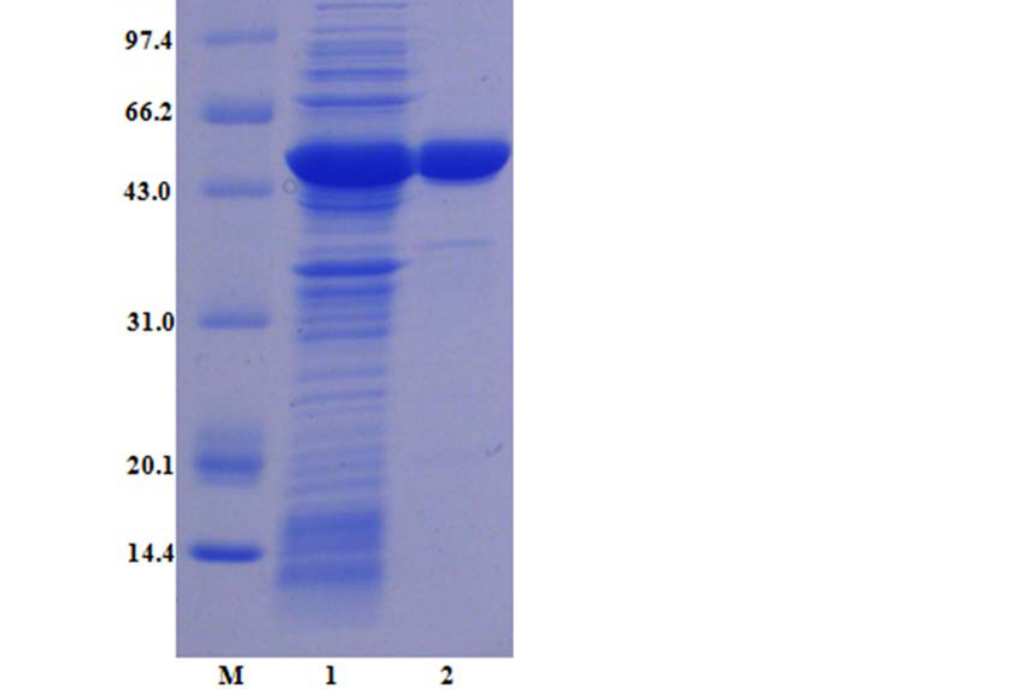
Figure 2. SDS-PAGE analysis of purified LcFFase1s. Lane M, low molecular weight standard protein markers; lane 1, crude lysate; lane 2, purified LcFFase1s. Table 1. Summary of the recombinant β -D-fructofuranosidase (LcFFase1S) expressed in E. coli